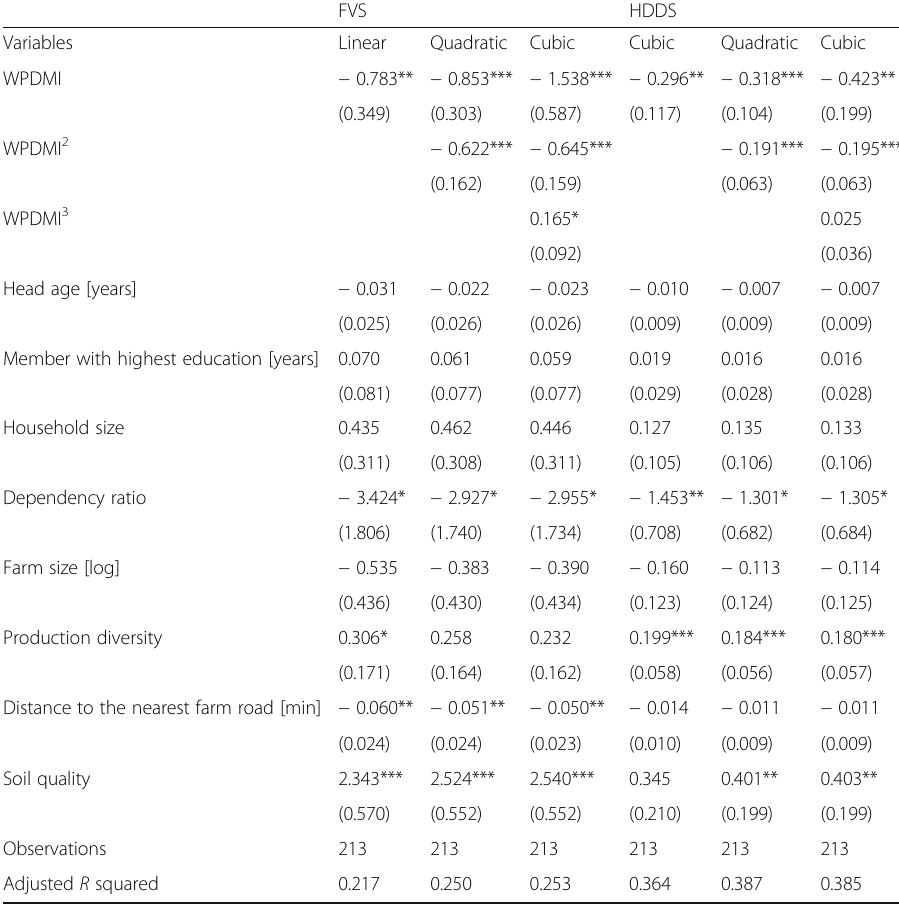
Table 4 Linear, quadratic, and cubic estimations of WPDMI on FVS and